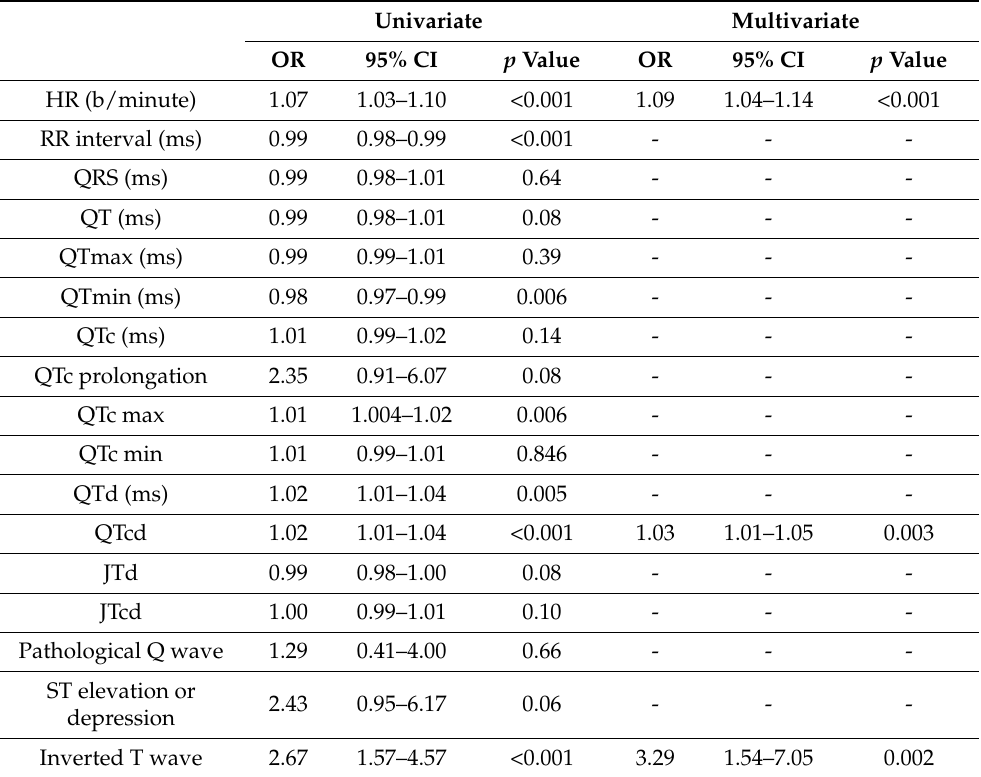
Table 2. Binary logistic regression analysis shows the association between ECG parameters at baseline and death. Due to the number of events (death N = 28), three unrelated variables were included in the multivariate